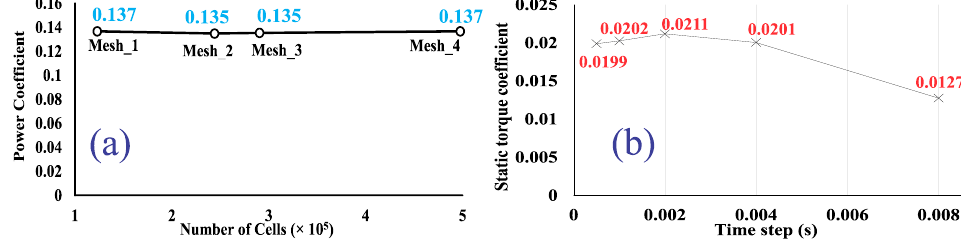
Figure 4. ( a ) Grid independency, ( b ) time step independency.